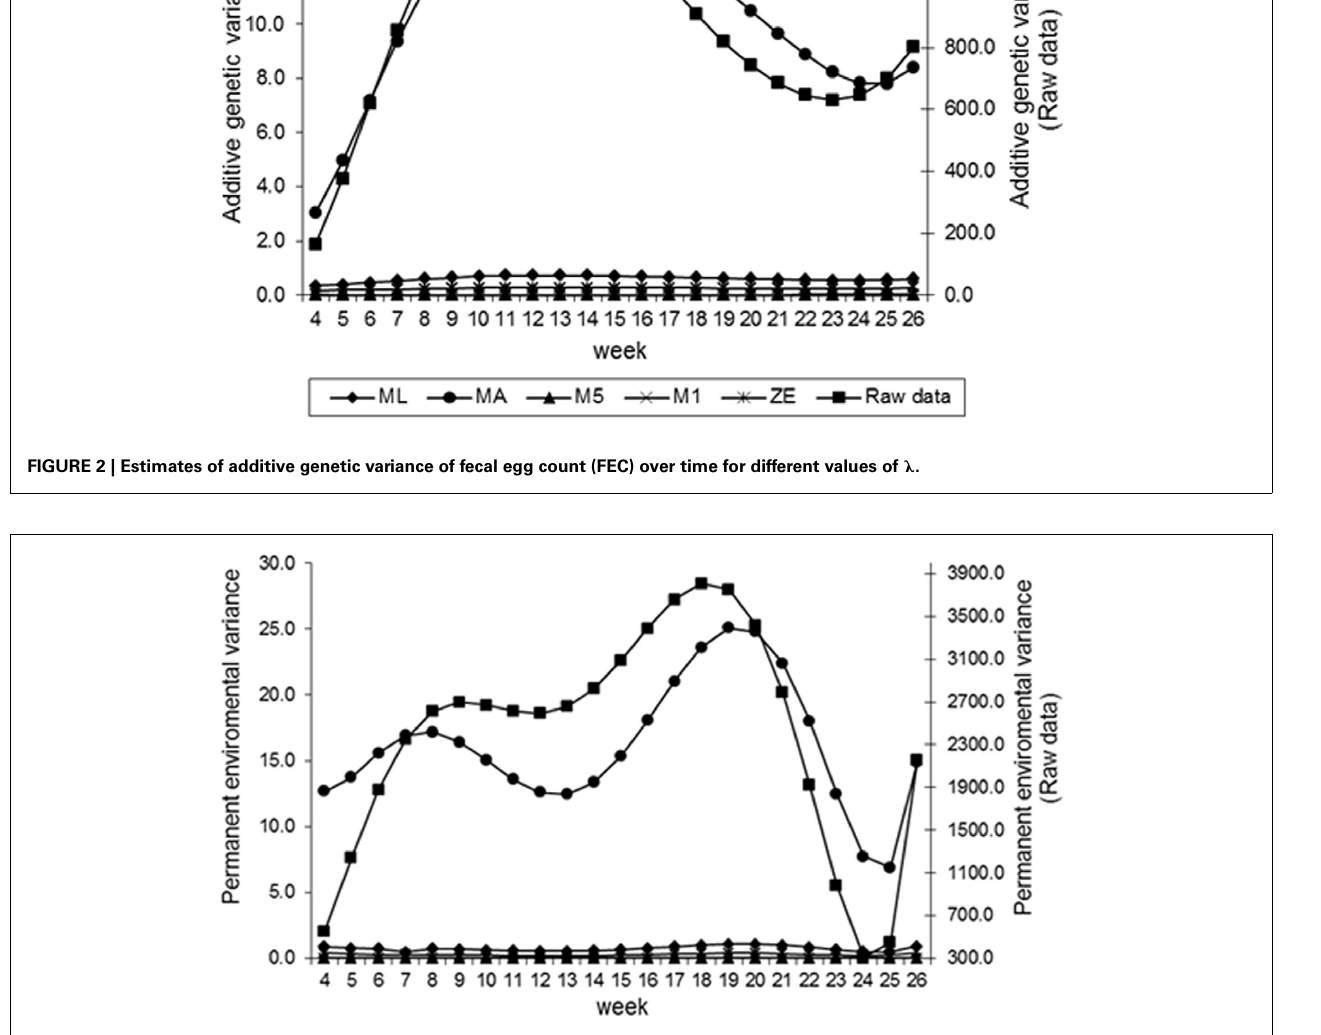
vary with values of λ used in transforming FEC. Greater